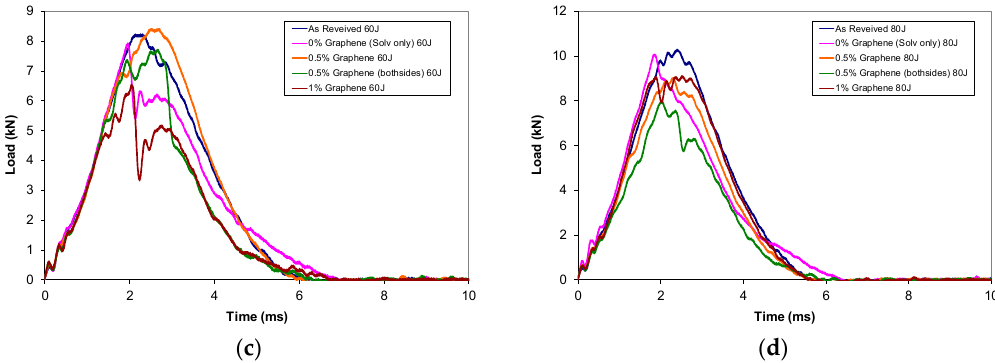
Figure 13. Load vs. time of glass fiber composites under impact ( a ) 20 J, ( b ) 40 J, ( c ) 60 J, and ( d ) 80 J. Table 1. Peak load and absorbed energy.